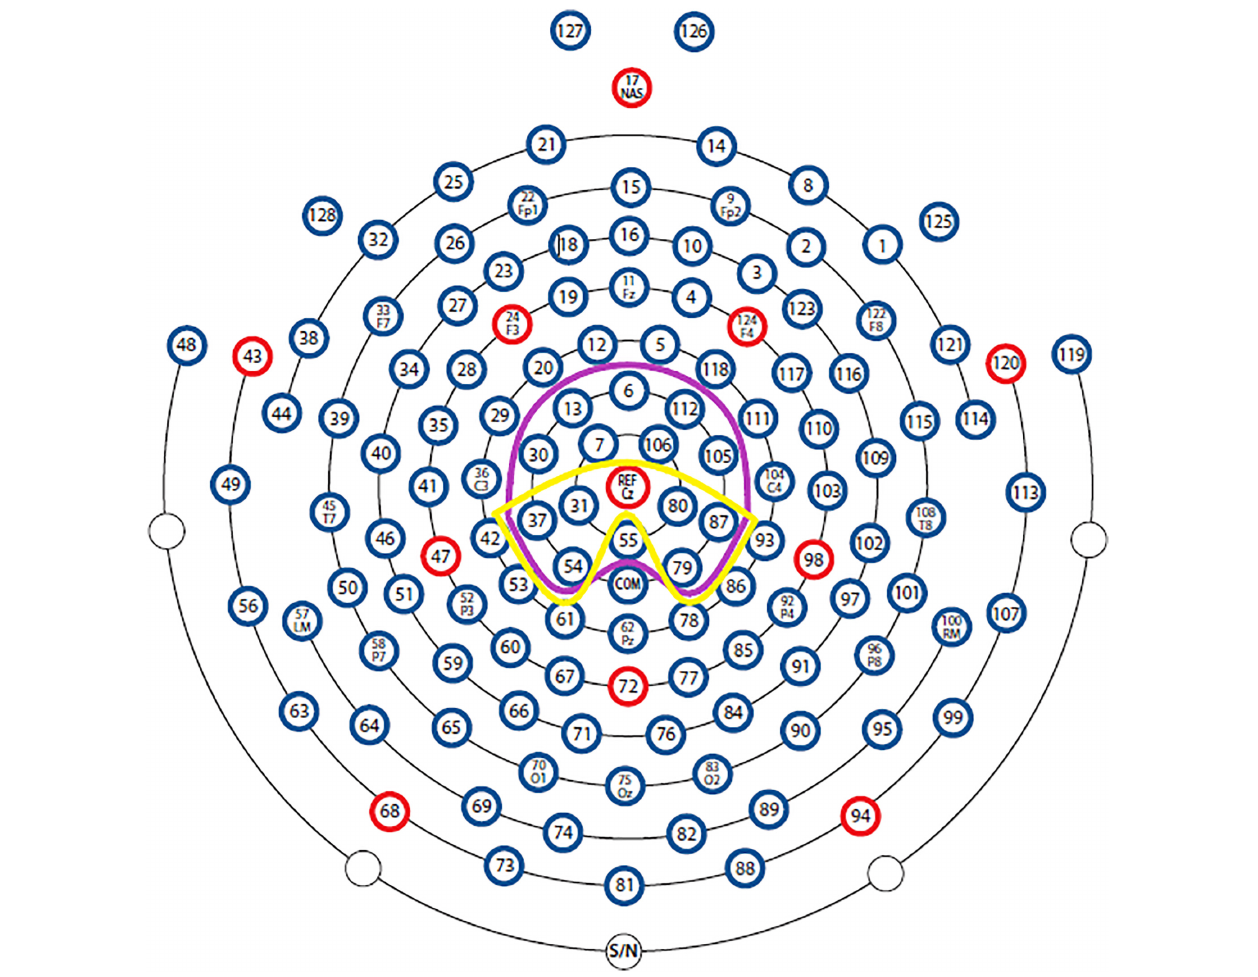
FIGURE 1 | Sensor outline of the HydroCel Geodesic Sensor Net (with permission from Electrical Geodesics, Inc. Electrodes). The LPC and N400 were calculated with the sensors framed with yellow and purple color, respectively.